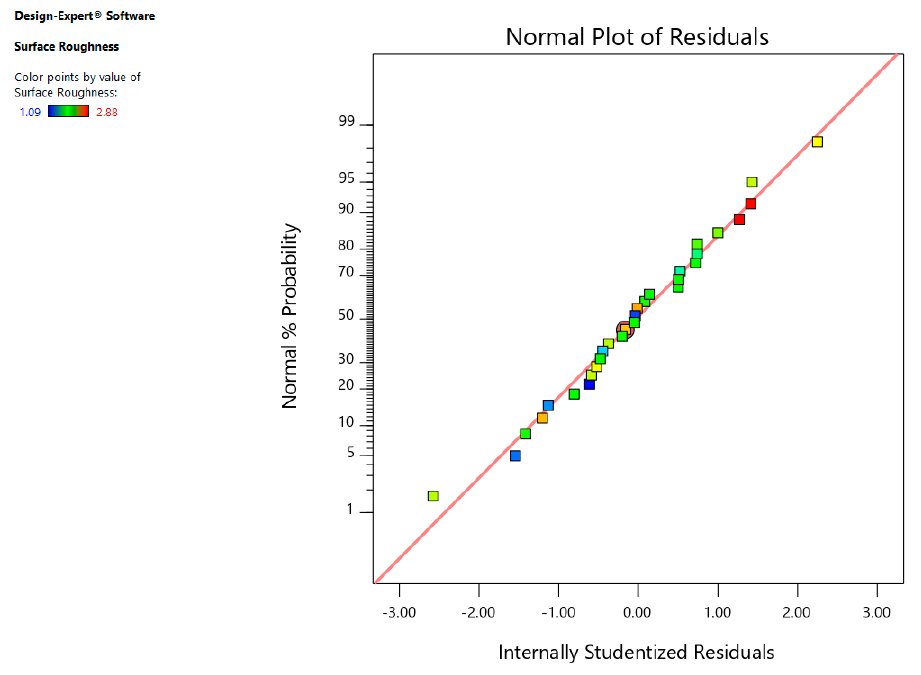
Figure 9. Normal chart of residual for surface roughness (SR).